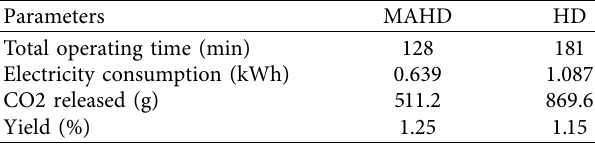
Table 3: Summary of energy consumption and CO MAHD and HD methods.